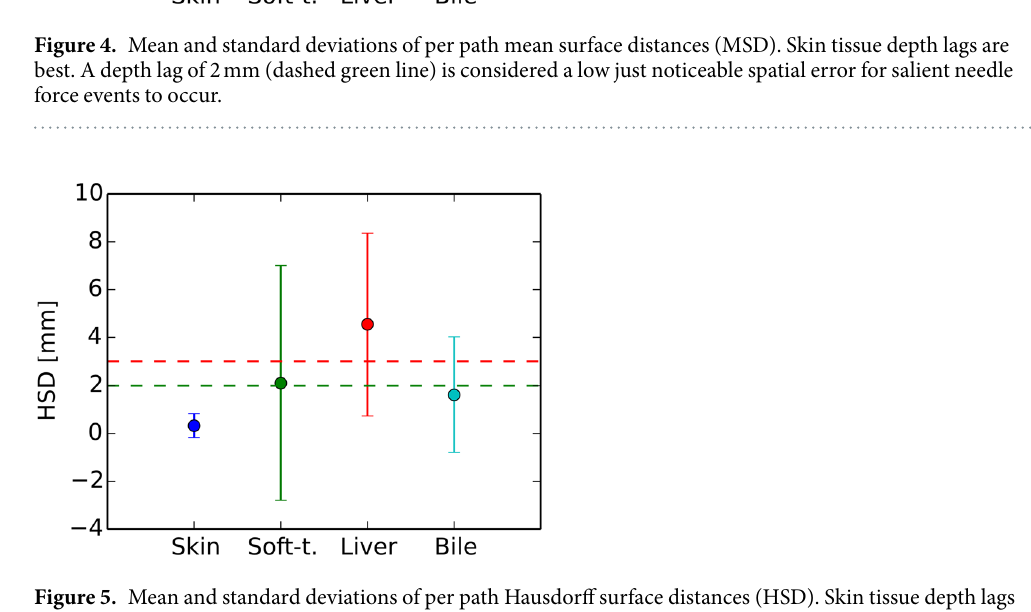
Figure 5. Mean and standard deviations of per path Hausdorff surface distances (HSD). Skin tissue depth lags are best. A depth lag of 3 mm (dashed red line) is considered a just noticeable spatial error for salient needle force events to occur.